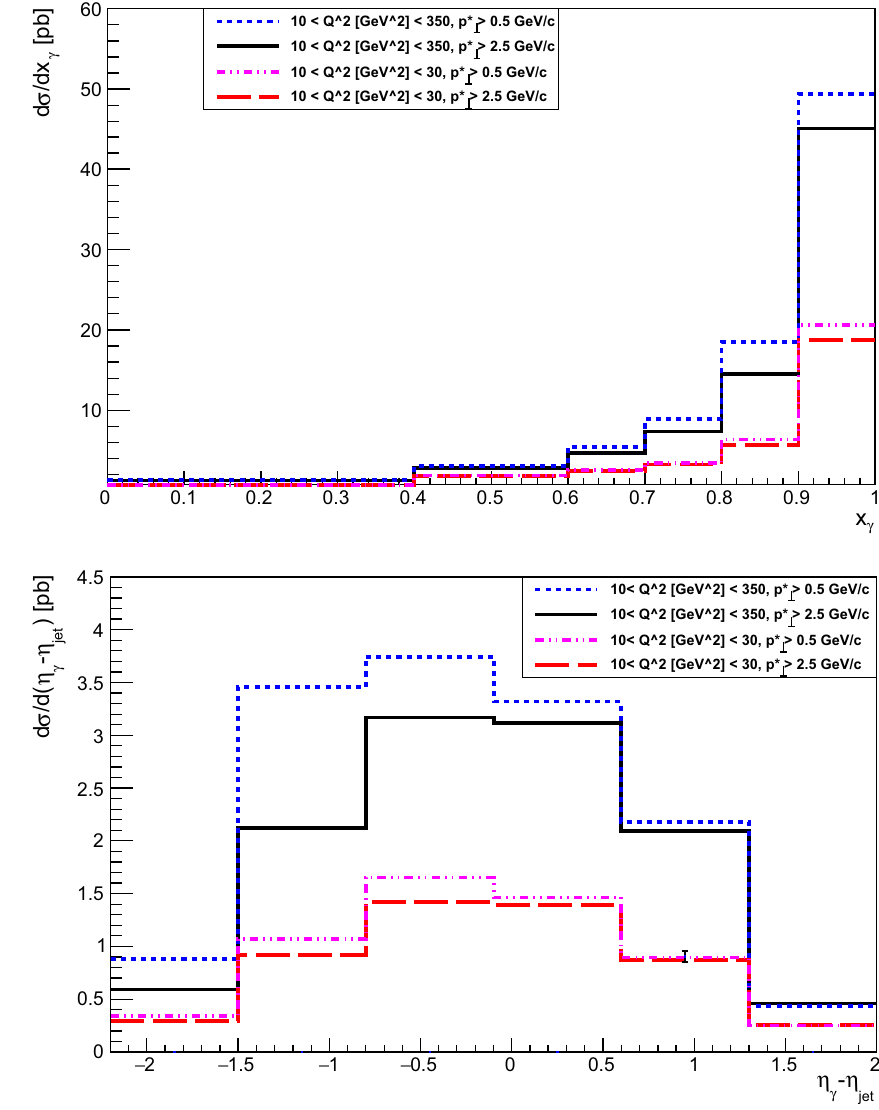
Fig. 1 d σ/ d x γ cross sections